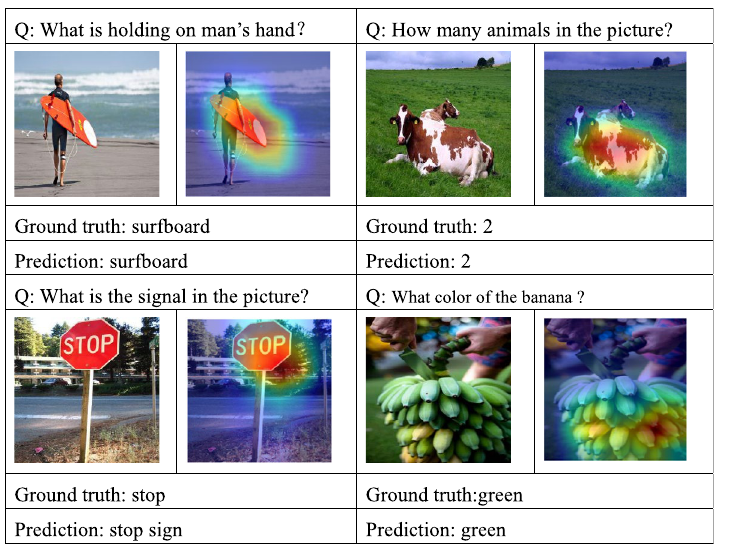
Figure 5. Visualization